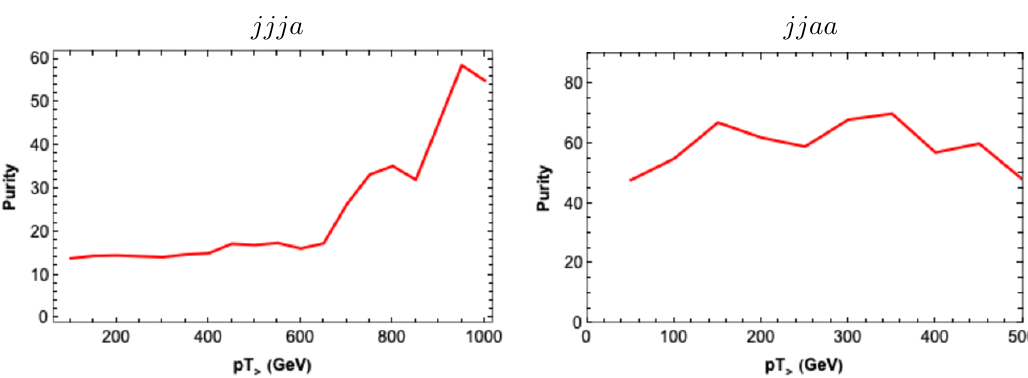
Figure 7 . Purity of the jjja (left) and jjaa (right) samples. In the former, pollution comes from jjjj events; for the latter, pollution derives from jjj(cid:13)